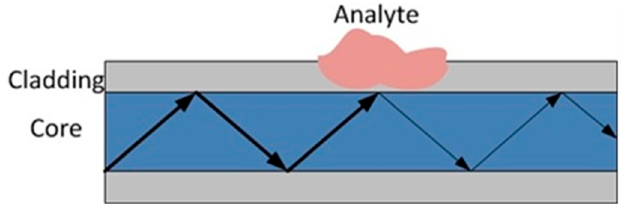
Figure 11. Illustration of chemical sensing based on light guidance loss. The presence of analyte in the cladding may change the guidance condition of the fibre, modifying the loss properties. The weight of the line represents the optical power.